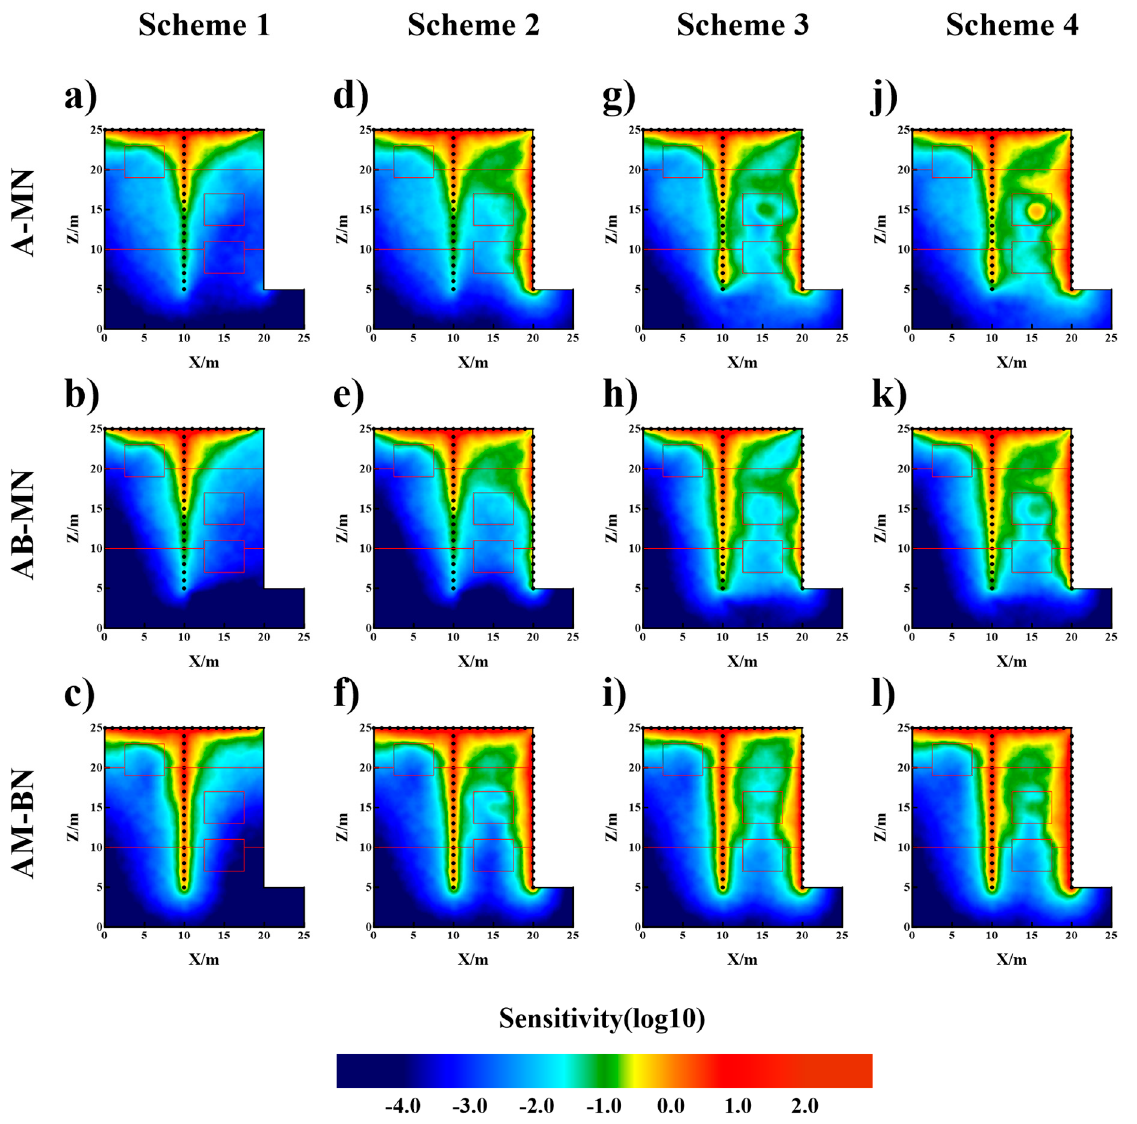
Figure 6. Sensitivity patterns for four combined schemes: ( a – c ) surface ERT scheme & BS-ERT scheme, ( d – f ) surface ERT scheme, BS-ERT scheme & SC-ERT scheme, ( g – i ) surface ERT scheme, BS-ERT scheme & BC-ERT scheme, ( j – l ) surface ERT scheme, BS-ERT scheme, SC-ERT scheme, BC-ERT scheme & cliff ERT scheme.